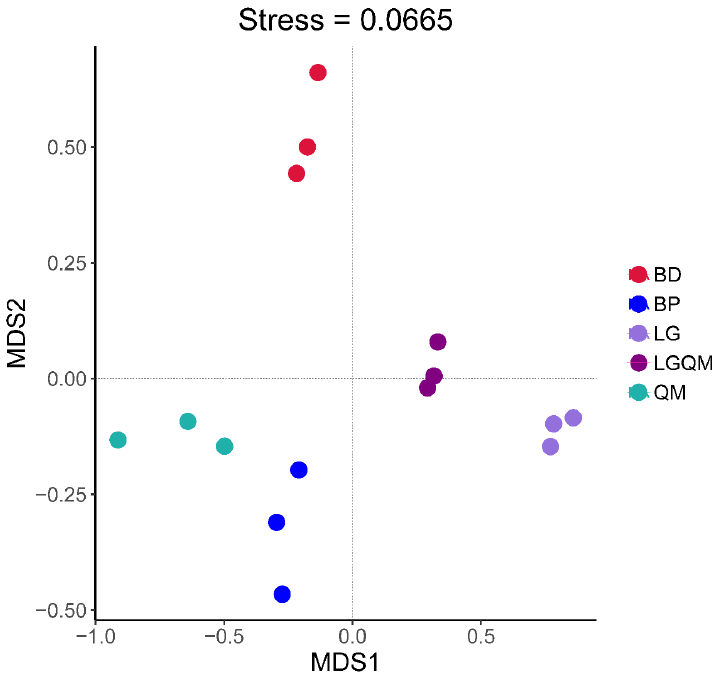
Figure 6. NMDS analysis of the fungal communities in the different forest type soils. BD, Betula dahurica ; BP, Betula platyphylla ; LG, Larix gmelinii ; LGQM, Q. mongolica and L. gmelinii mixed forest; QM, Quercus mongolica .